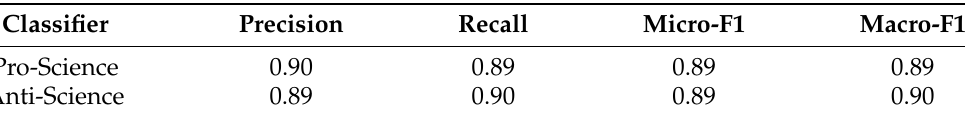
Table 2. Cross-validation results of pro-science and anti-science classifiers. Results are averaged